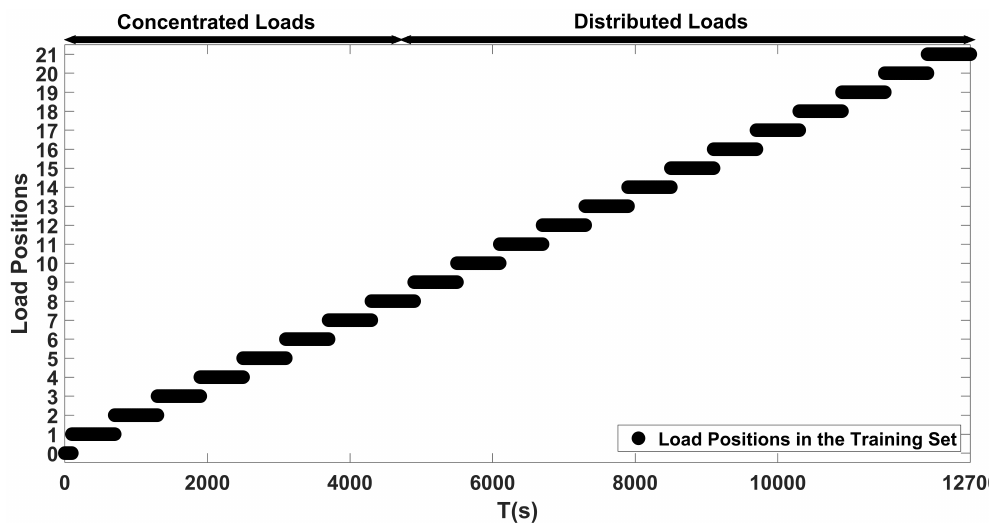
Figure 14. Load positions used for training the proposed localization ANN.